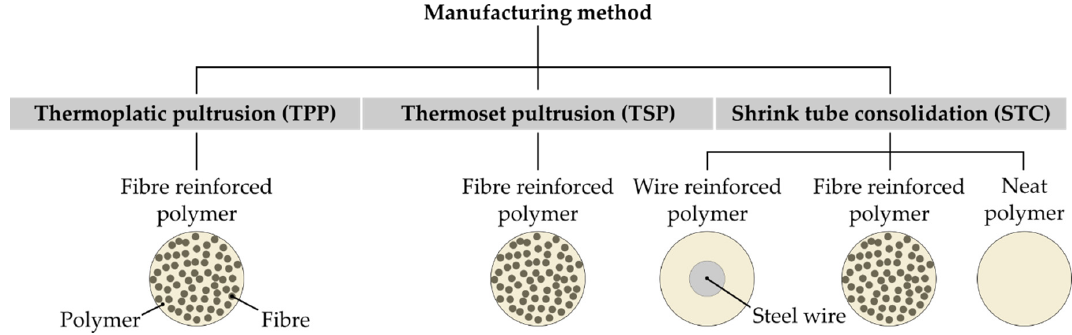
Figure 1. Overview of the investigated manufacturing methods and the fabricated semi-finished products.